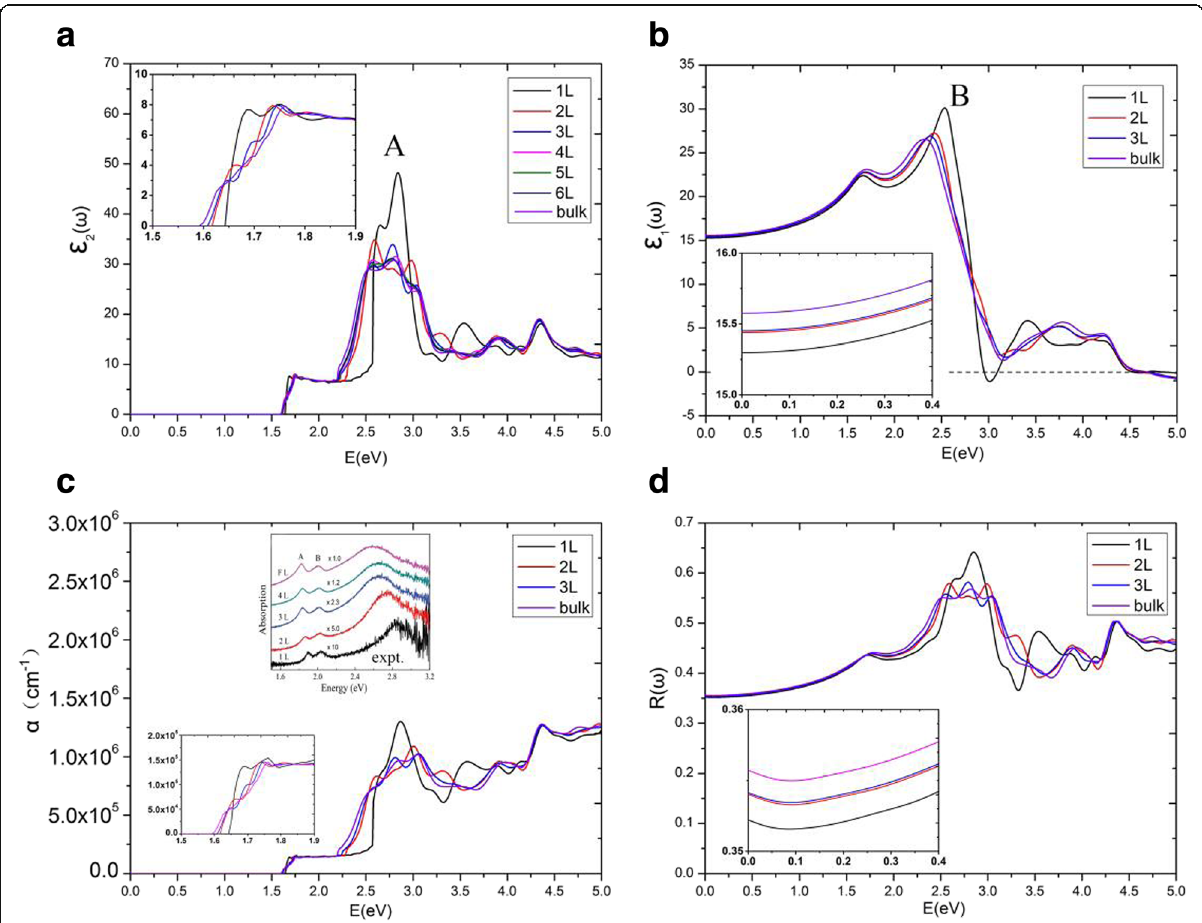
Fig. 6 a The imaginary parts of the dielectric function, b the real parts of the dielectric function, c the absorption coefficients, and d the reflectivity spectra, for different number of MoS 2 layers. The inset in c also shows the experimental data